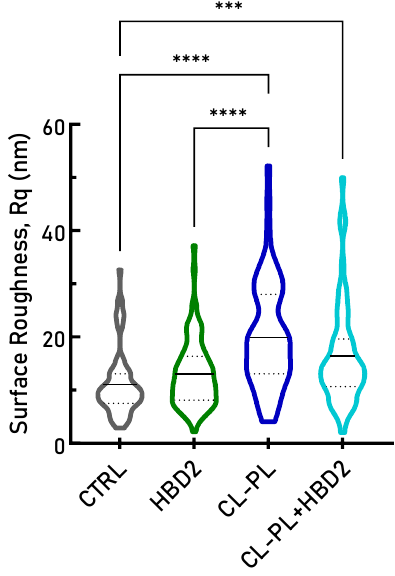
Figure 2. Individual bacterial surface roughness after treatment with HBD2 and CL-PL alone and in combination. PACF was incubated for 18 h in the presence of CL-PL ± HBD2 or solvent control (CTRL), followed by AFM scanning of adherent bacteria to obtain bacterial surface roughness data (derived from the central 40% of the bacterial surface, see Figure A1 for detailed calculation). CL concentration was 125 µ g/mL, and HBD2 concentration was 0.25 µ M. The solid line in the violin plots represents sample mean, and the dashed lines represent the first and third quartiles; n = 68 for CTRL, n = 62 for HBD2, n = 89 for CL-PL, and n = 74 for CL-PL + HBD2. *** indicates p < 0.001, and **** indicates p < 0.0001 in one-way ANOVA with Tukey’s post hoc analysis. In addition, CL-PL + HBD2 also differed significantly from CL-PL alone and HBD2 alone ( p < 0.05). Treatment with CL-PL effected a statistically significant increase in bacterial surface roughness (20.13 ± 10.01 nm, mean ± SD, n = 89, p < 0.0001), compared to the solvent control (11.09 ± 6.08 nm, mean ± SD, n = 68) and HBD2 (13.01 ± 6.22, mean ± SD, n = 62). CL-PL + HBD2 also effected a significant increase of surface roughness (16.30 ± 9.28 nm, n = 74), compared to the solvent control ( p = 0.0008) and HBD2 ( p = 0.0468), though to a lesser degree than for CL-PL alone ( p = 0.0296). Though surface roughness appeared to be shifted to higher values for HBD2 alone, compared to the control, this trend did not reach statistical significance. These data suggest that CL-PL induces significant changes to the surface topography of PACF. 2.1.2. AFM Reveals Loss of Extracellular Network Surrounding PACF after Treatment with CL-PL and HBD2 Alone and Combined While scanning the surfaces of adherent bacteria, we also noticed an alteration of the extracellular matrix surrounding the bacteria. PA and other biofilm-producing bacteria are known to produce extracellular structures early on during the biofilm formation process [2,49,50]. We observed a trend where many solvent control-treated bacteria exhibited extracellular structures that radiated outward — sometimes towards and surrounding nearby bacteria, which was absent in images from bacteria treated with CL- PL, HBD2, and CL-PL + HBD2 (Figure 3), suggesting that the organization of the biofilm matrix was interrupted by these treatments.